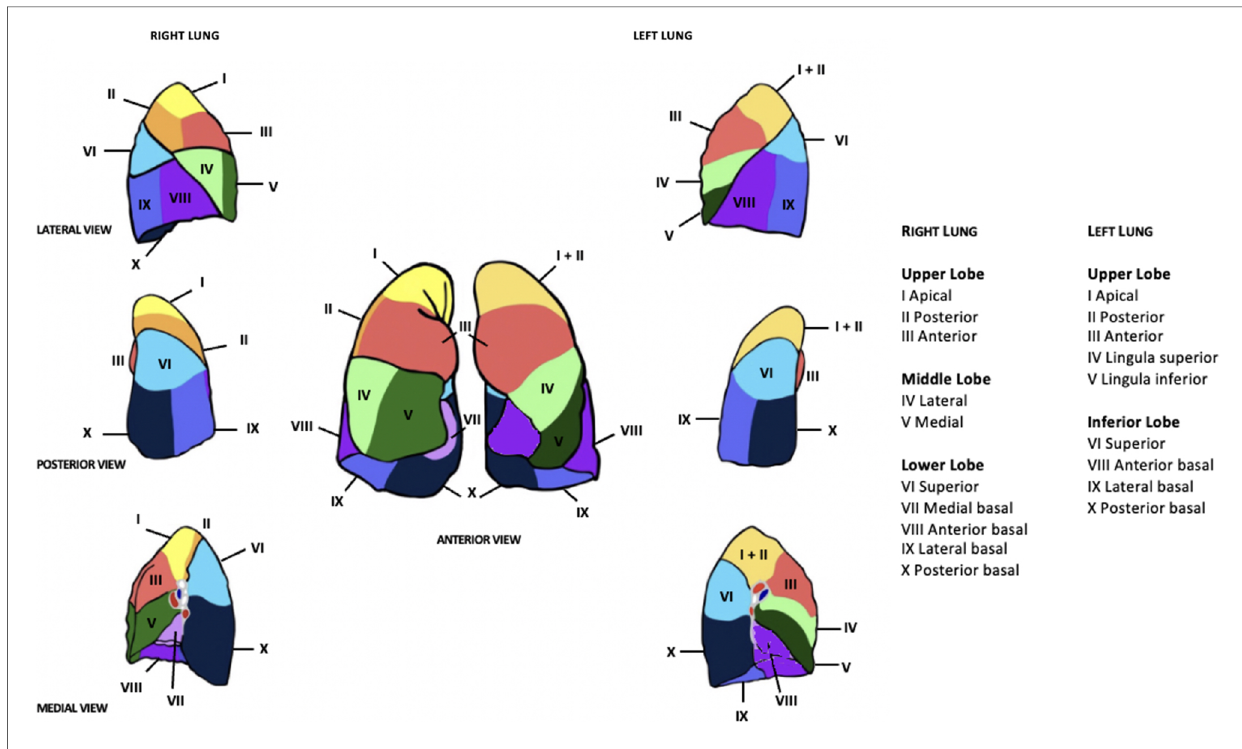
FIGURE 1 Lung segments by Elisabeth Savonitto.